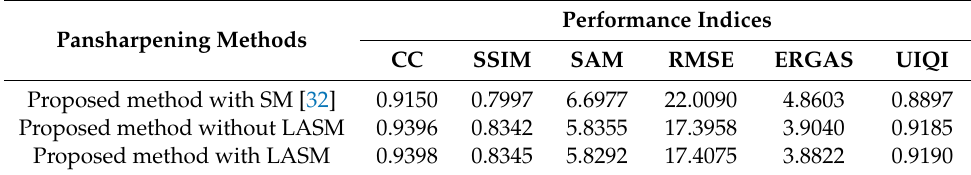
Table 1. Performance evaluation results of Figure 1. CC, correlation coefficient; SSIM, structural similarity; SAM, spectral angle mapper; RMSE, root mean square error; ERGAS, erreur relative globale adimensionnelle de synthèse; UIQI, universal image quality index.